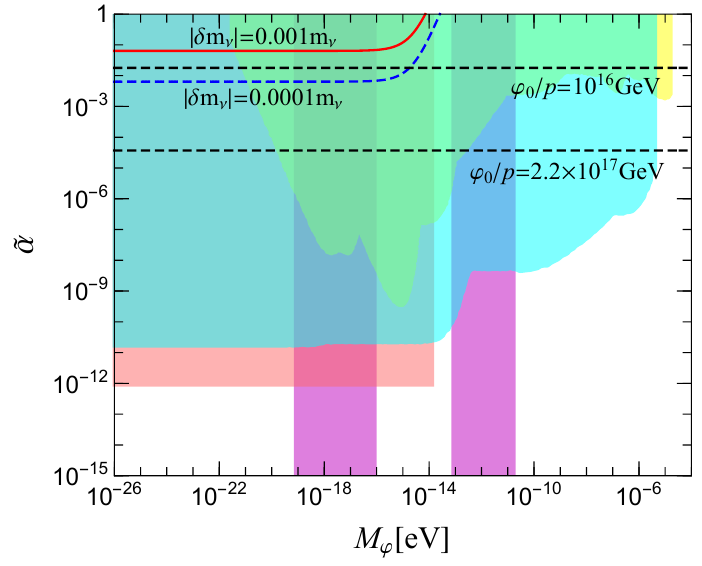
Figure 2 . The red (blue) contour shows j (cid:14)m (cid:23) (0) =m (cid:23) j = 0 : 001(0 : 0001), for q=p = 1. The combina- tion n 0 F ( M (cid:11) R ) is the one of eq. (2.9), with n e ( r ) from refs. [14, 15]. The vertical bands in purple are e excluded from black hole superradiance. The other colored regions are excluded by tests of the New- ton law: yellow from test of ISL and blue and pink from tests of the EP for interaction range larger than 1cm, see the discussion in sections 2.1 and 2.3. Also shown are two dashed contours of ’ 0 =p